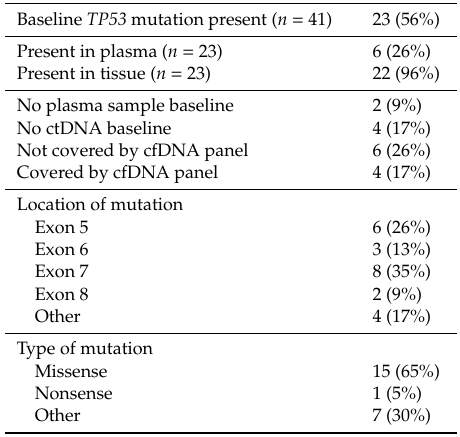
Table 3. TP53 status at